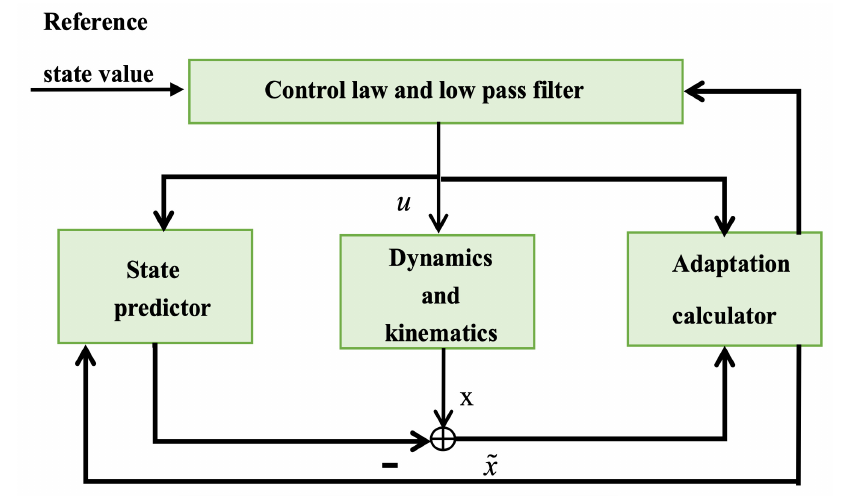
Figure 1. L 1 adaptive